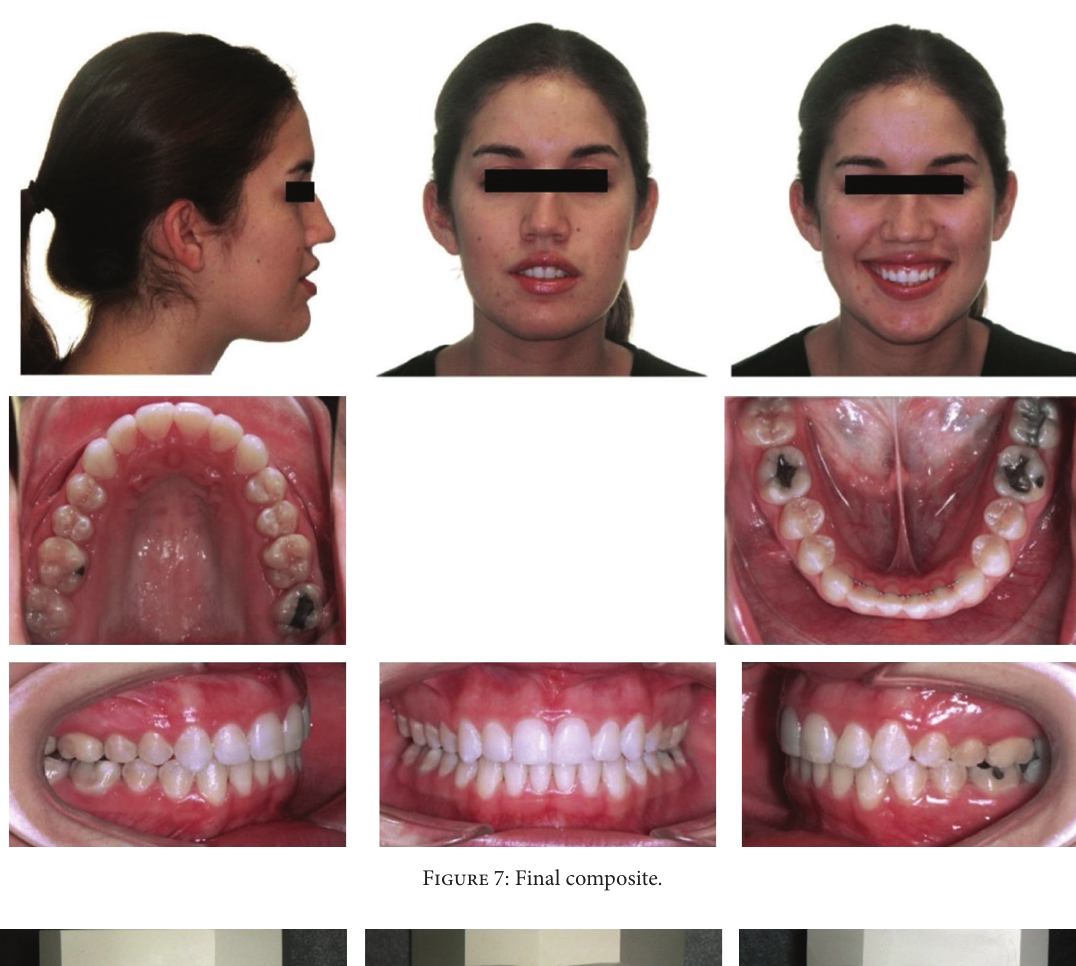
Figure 7: Final composite.